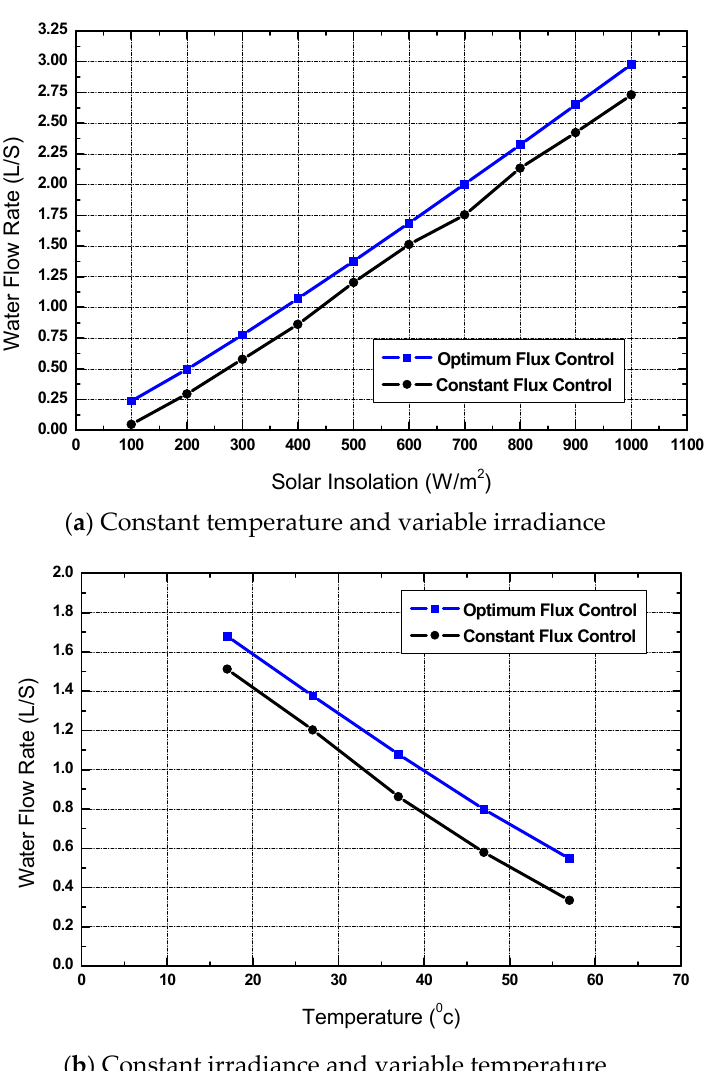
Figure 9. Water flow rate variation.